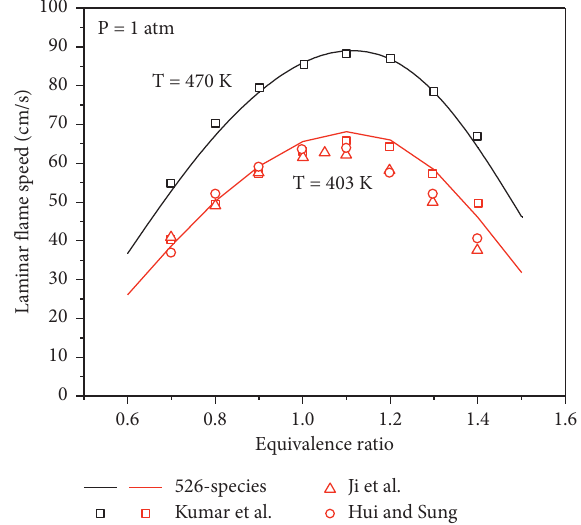
Figure 2: Laminar flame speed validation for n-dodecane at an equivalence ratio of 0.6–1.5, atmospheric pressure, and unburned fuel temperatures of 403 and 470K. The experimental data used for comparison were taken from Kumar and Sung [47], Ji et al. [48], and Hui and Sung